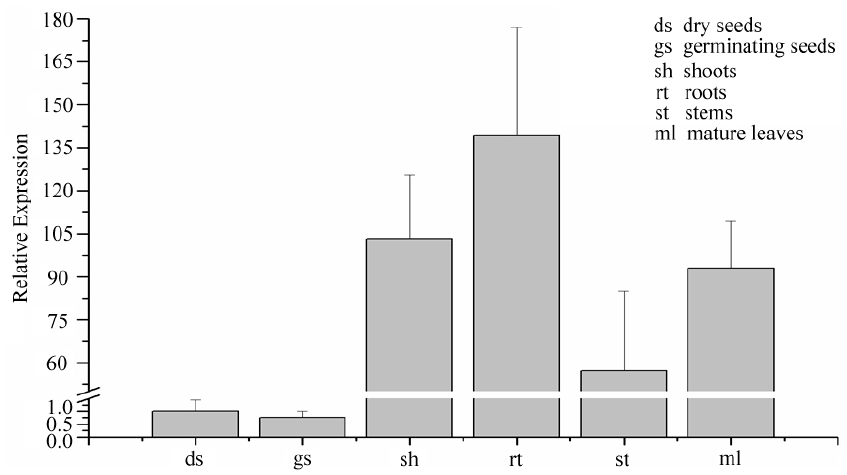
Figure 4. Quantitative reverse transcription-polymerase chain reaction analysis of Ls-CAS gene in different tissues of L. sativus .